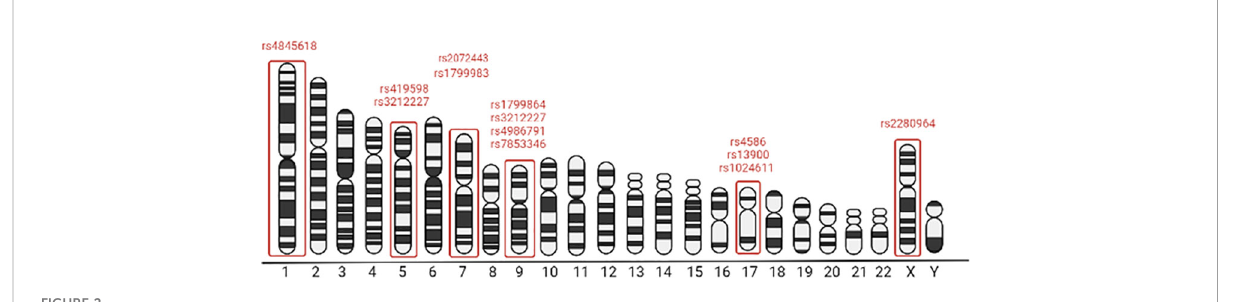
FIGURE 2 Chromosomal localisation of SNPs associated with the monocytes ’ involvement in the cancer therapy effects. Figure created in biorender